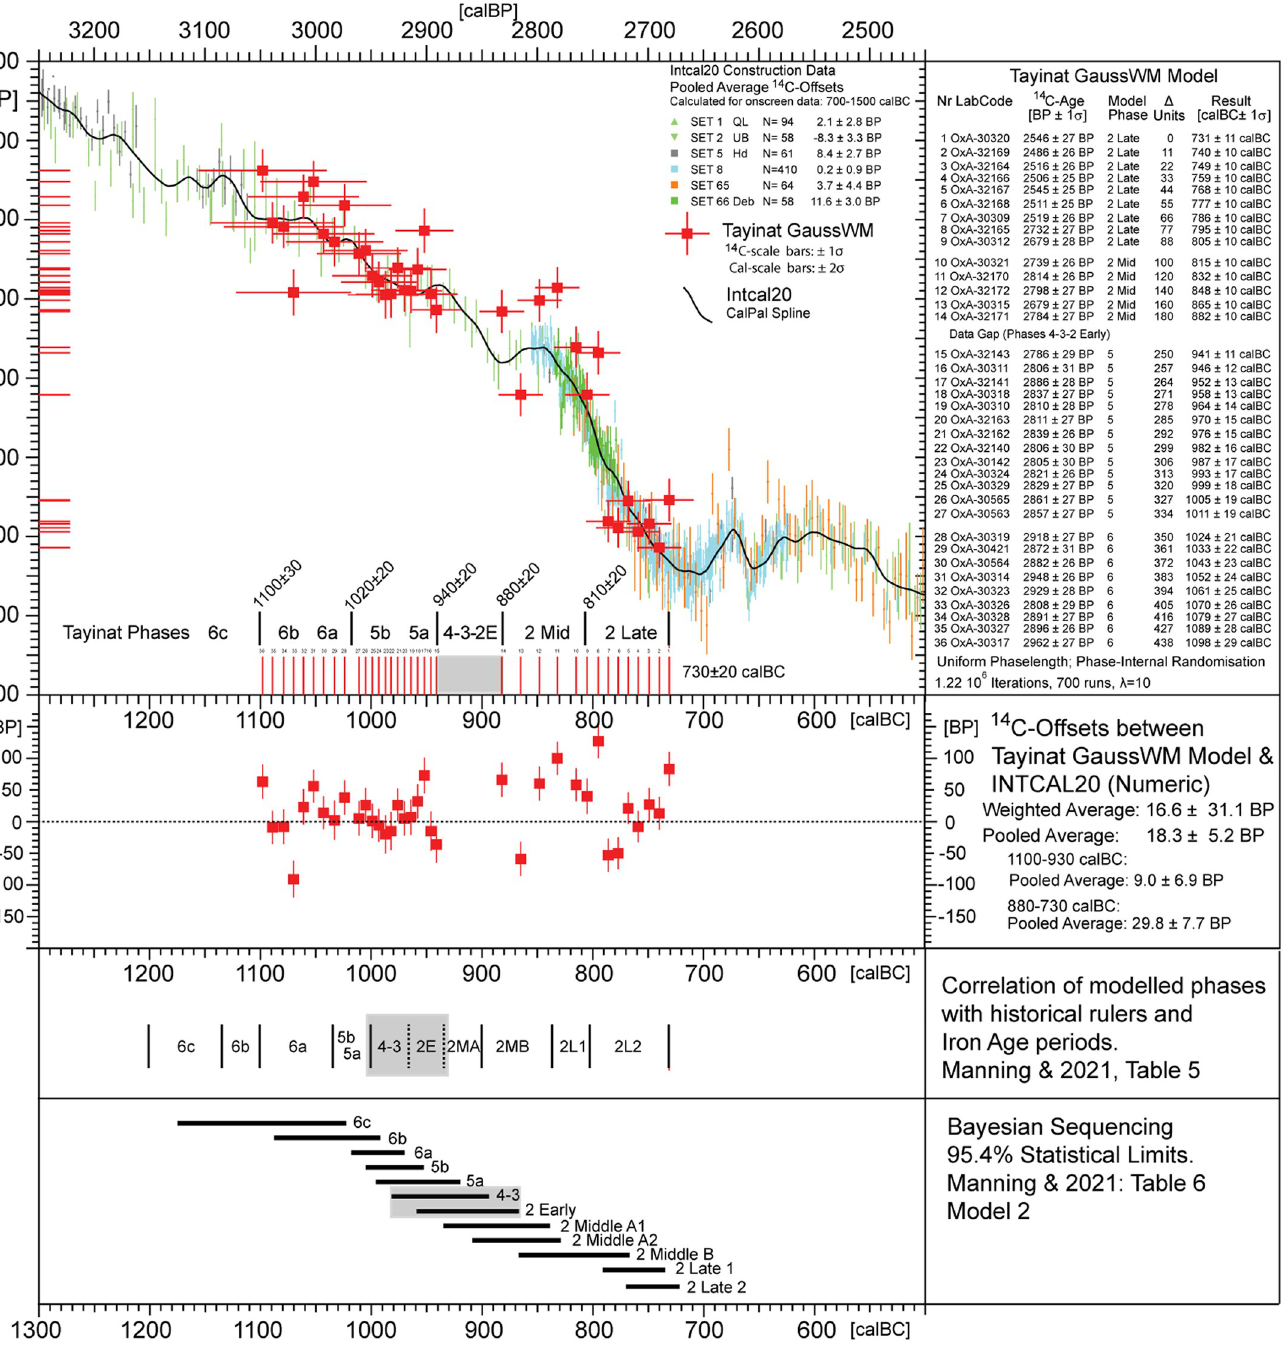
Fig 9. Fig.X3 GaussWM-chronology for Tel Tayinat, based on the same 14 C-data (N = 50) as published by [28], and using an equivalent archaeological age- model.